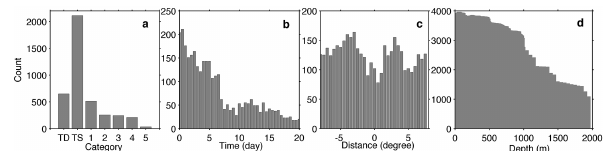
Figure A3. Histograms of the Argo float pairs for different statis- tics: (a) storm category, (b) time after storm passage (0.5-day bin), (c) distance from the storm center (0.5 ◦ bin), and (d) depth (10m bin). In (c) , a positive distance represents the right (left) side of the track in the Northern Hemisphere (Southern Hemisphere), and a negative distance represents the left (right) side in the Southern Hemisphere (Northern